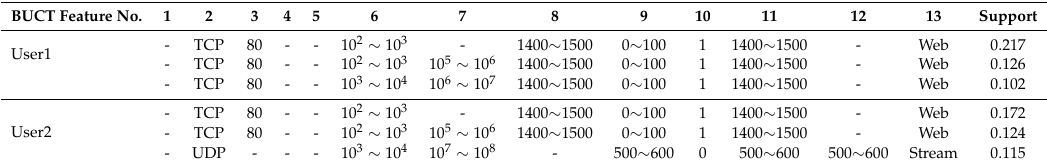
Table 5. User behavior patterns of BUCT.